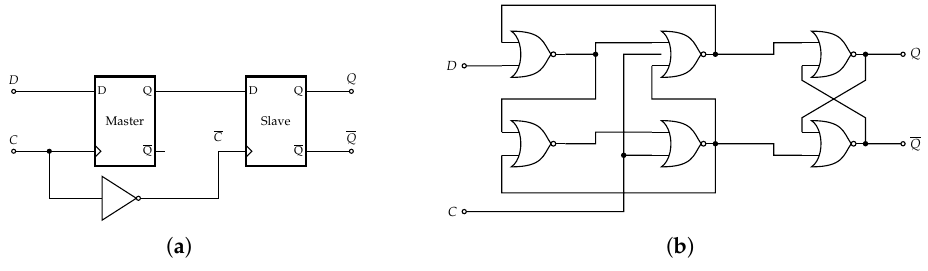
Figure 8. D-type flip-flops. ( a ) Master-slave DFF. ( b ) 6-NOR DFF.